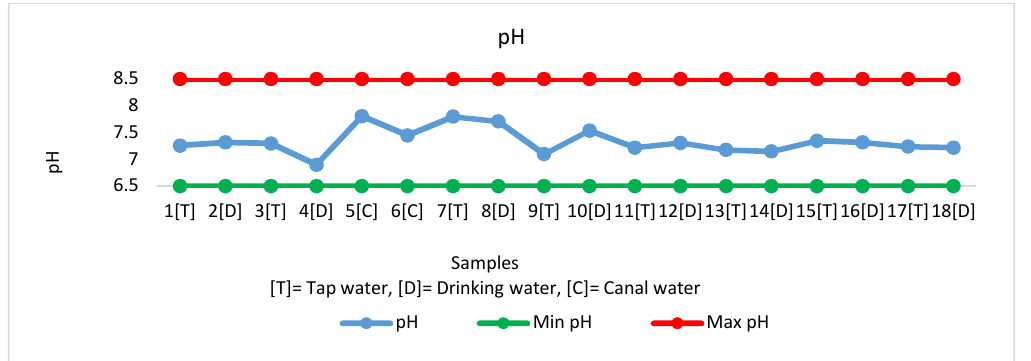
Fig. 2: pH Results of 18 Samples taken from 6 locations in Nawabshah City